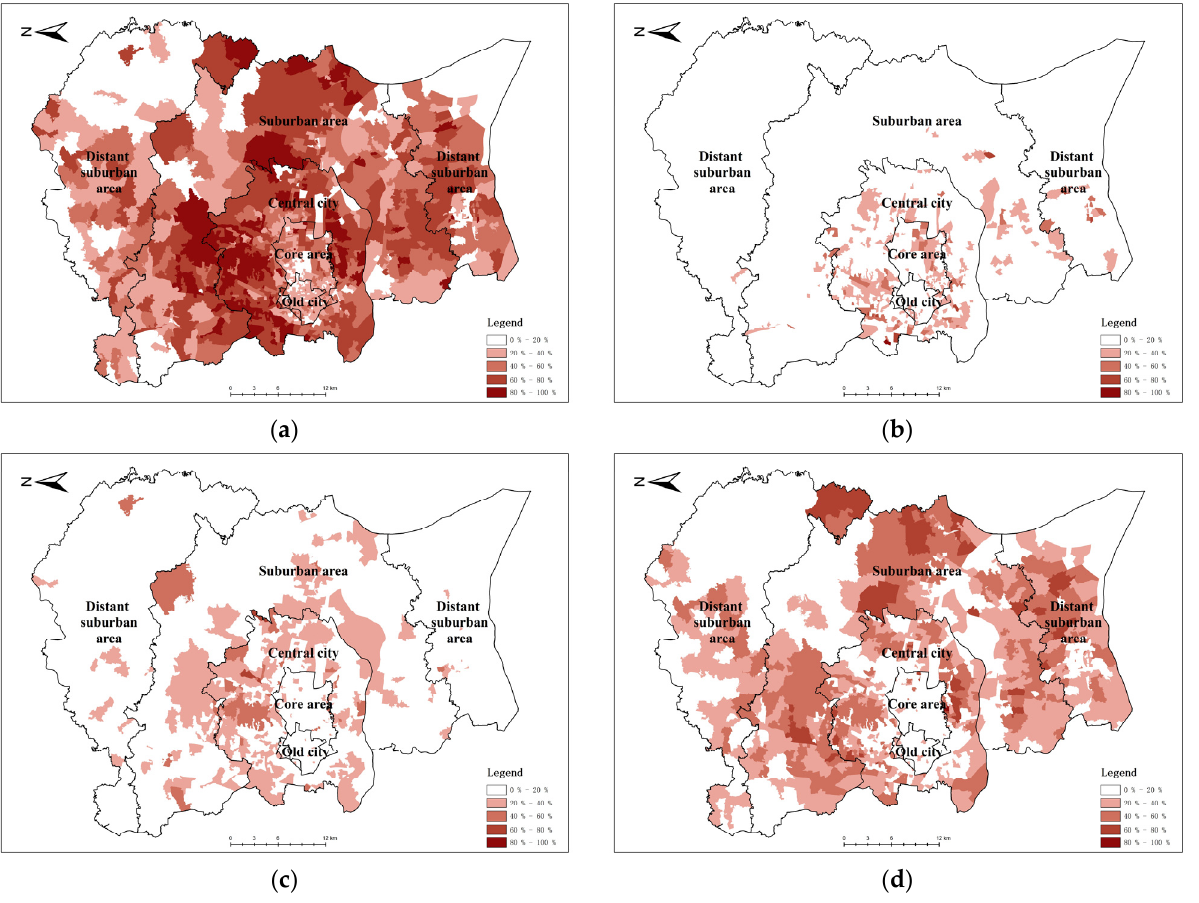
Figure 3. The spatial distribution of the floating population with different household registration. ( a ) The proportion of the entire floating population; ( b ) the proportion of the FPFOD; ( c ) the proportion of the FPFOC; ( d ) the proportion of the FPFOP.